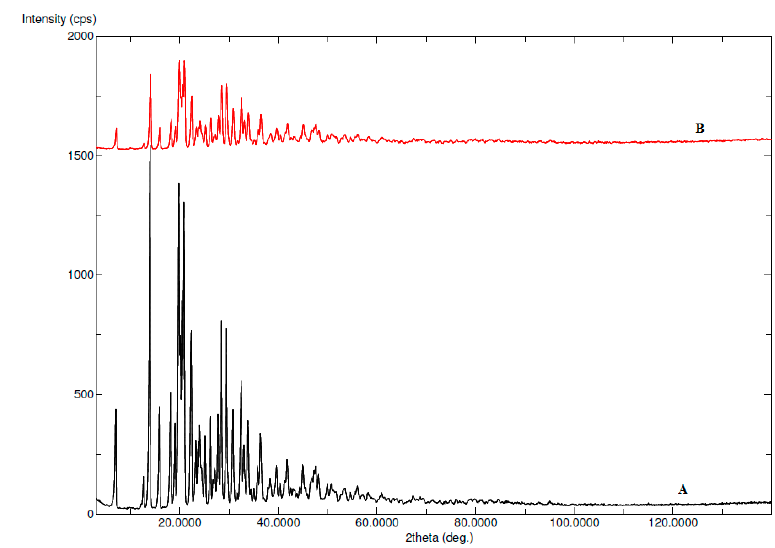
Figure 2. X-ray di ff raction pattern (XRD) spectra of ( A ) pure ECT and ( B ) equilibrated ECT (recovered Figure 2. X-ray diffraction pattern (XRD) spectra of ( A ) pure ECT and ( B ) equilibrated ECT from pure water). (recovered from pure water).